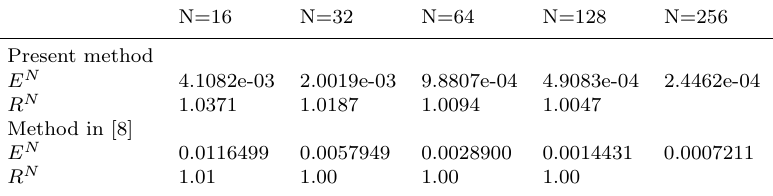
Table 4. Comparison of ε -uniform maximum absolute errors and rate of convergence for Example 2. N=16 N=32 N=64 N=128 N=256 Present method E